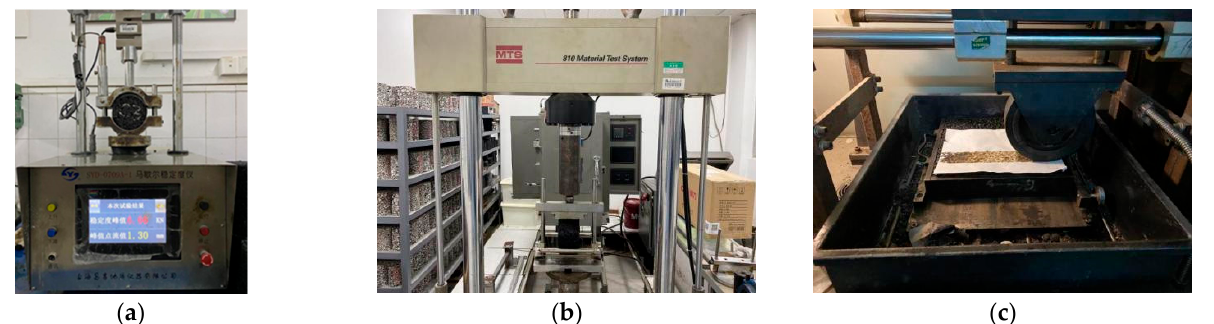
Figure 2. Standardized performance tests: ( a ) Marshall stability test; ( b ) tensile strength test; ( c ) dynamic stability test.